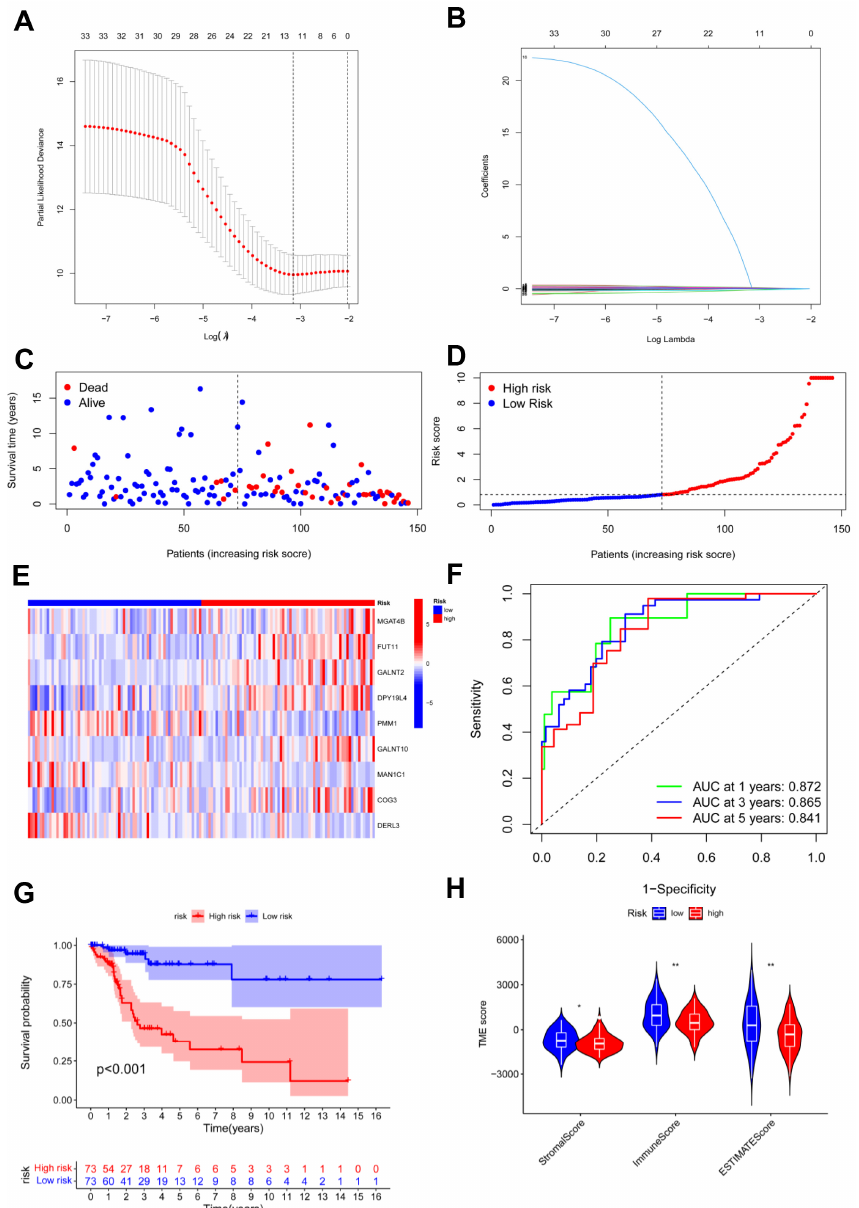
Figure 4. Identification and construction of risk model. ( A , B ) LASSO analysis with minimal lambda; ( C – D ) assessments of the survival status and risk scores in high- and low-risk groups; ( E ) the risk gene expression in the two groups; ( F ) ROC curve of the risk model; ( G ) survival curves in the two groups; ( H ) stromal, immune, and ESTIMATE scores of the two groups. * p < 0.05; ** p < 0.01.